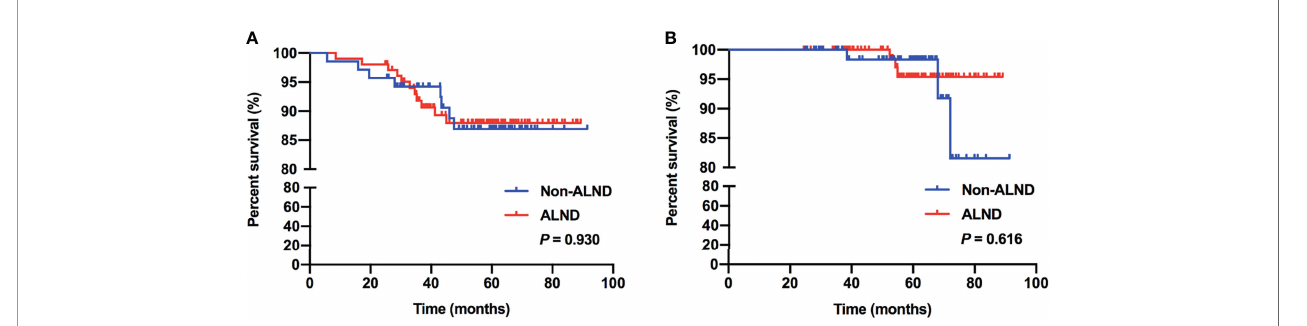
FIGURE 3 | RFS (A) and OS (B) in patients who met the inclusive criteria of the AMAROS